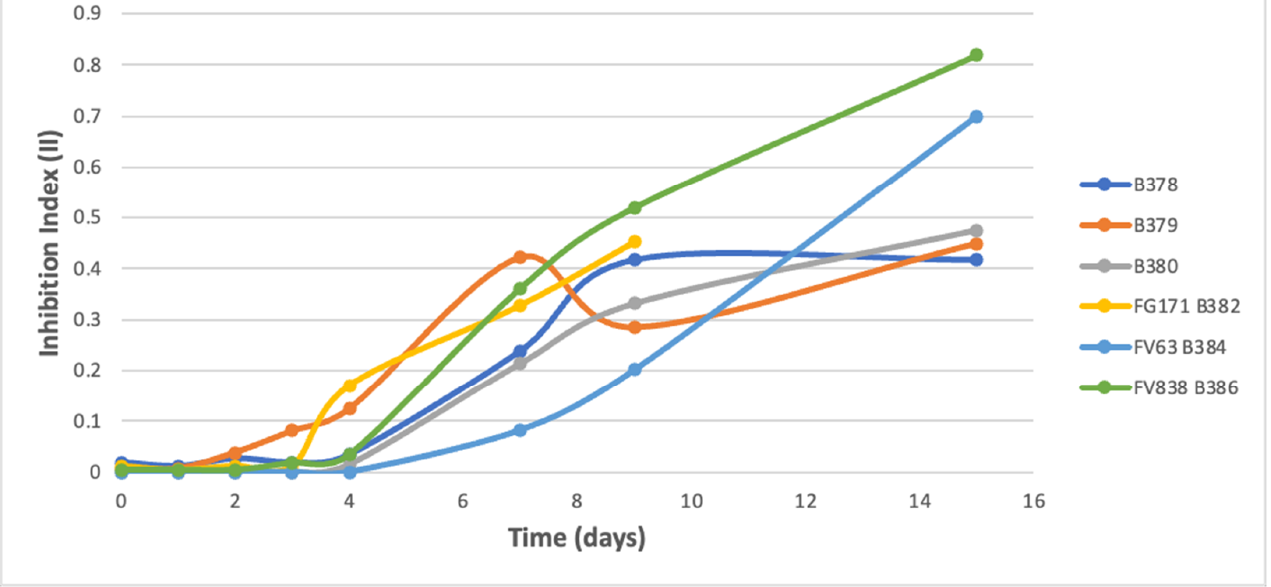
Table 4. Evaluation B. velezensis strain B25 biocontrol effect on fusarium seedling blight (FSB) syn-